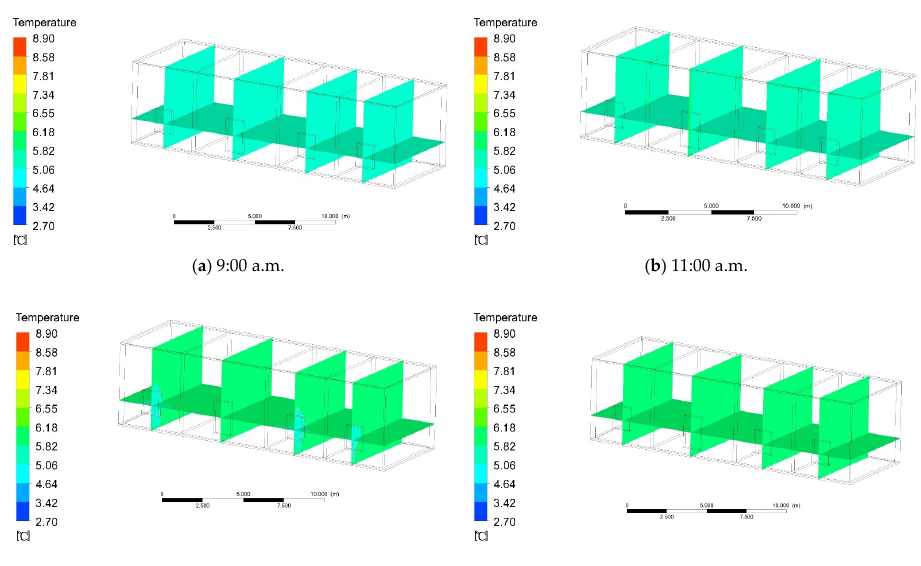
The temperature change of the ordinary system with WSR